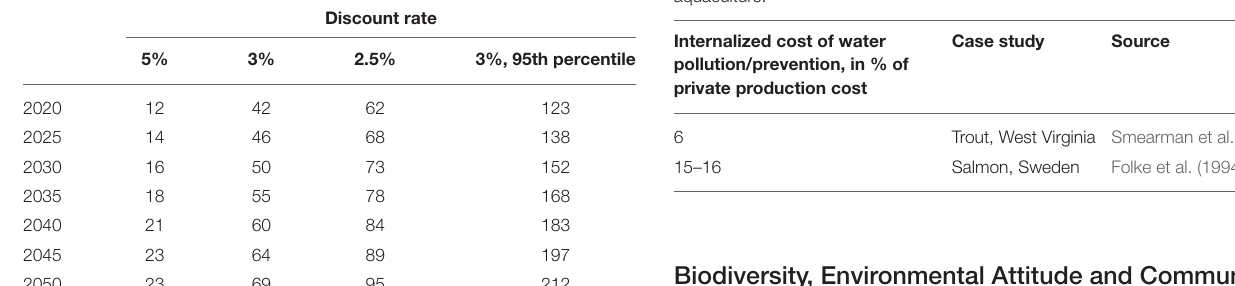
TABLE 5 | Social cost of CO2, in 2007 dollars per metric ton CO2 a . TABLE 6 | Quantified effects of water pollution and prevention costs in